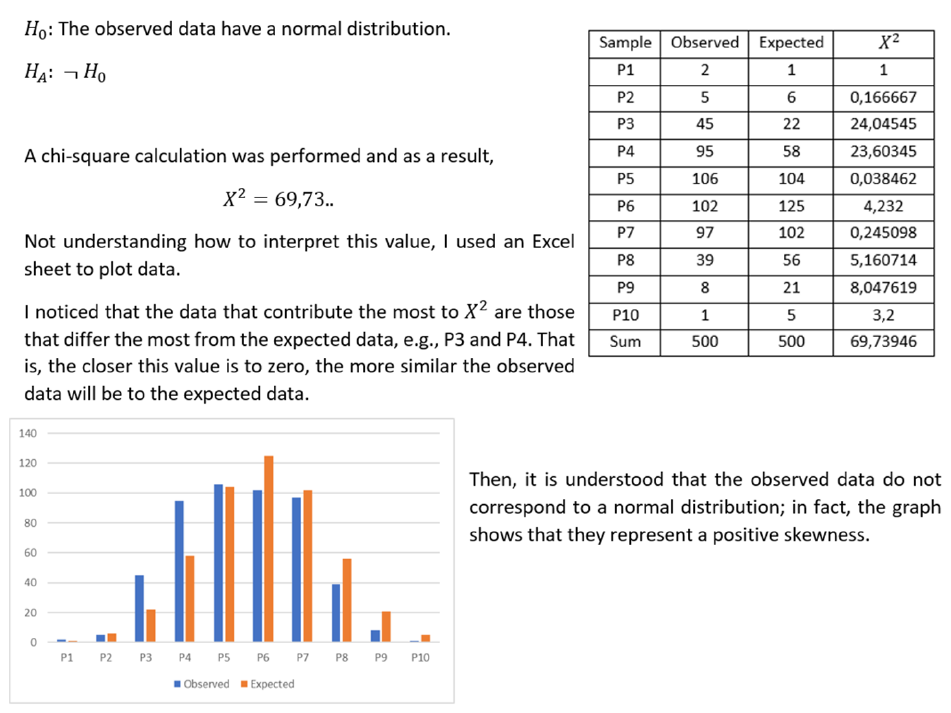
Figure 3. The practice of the prospective Teacher 21 (G2) on Activity 1.